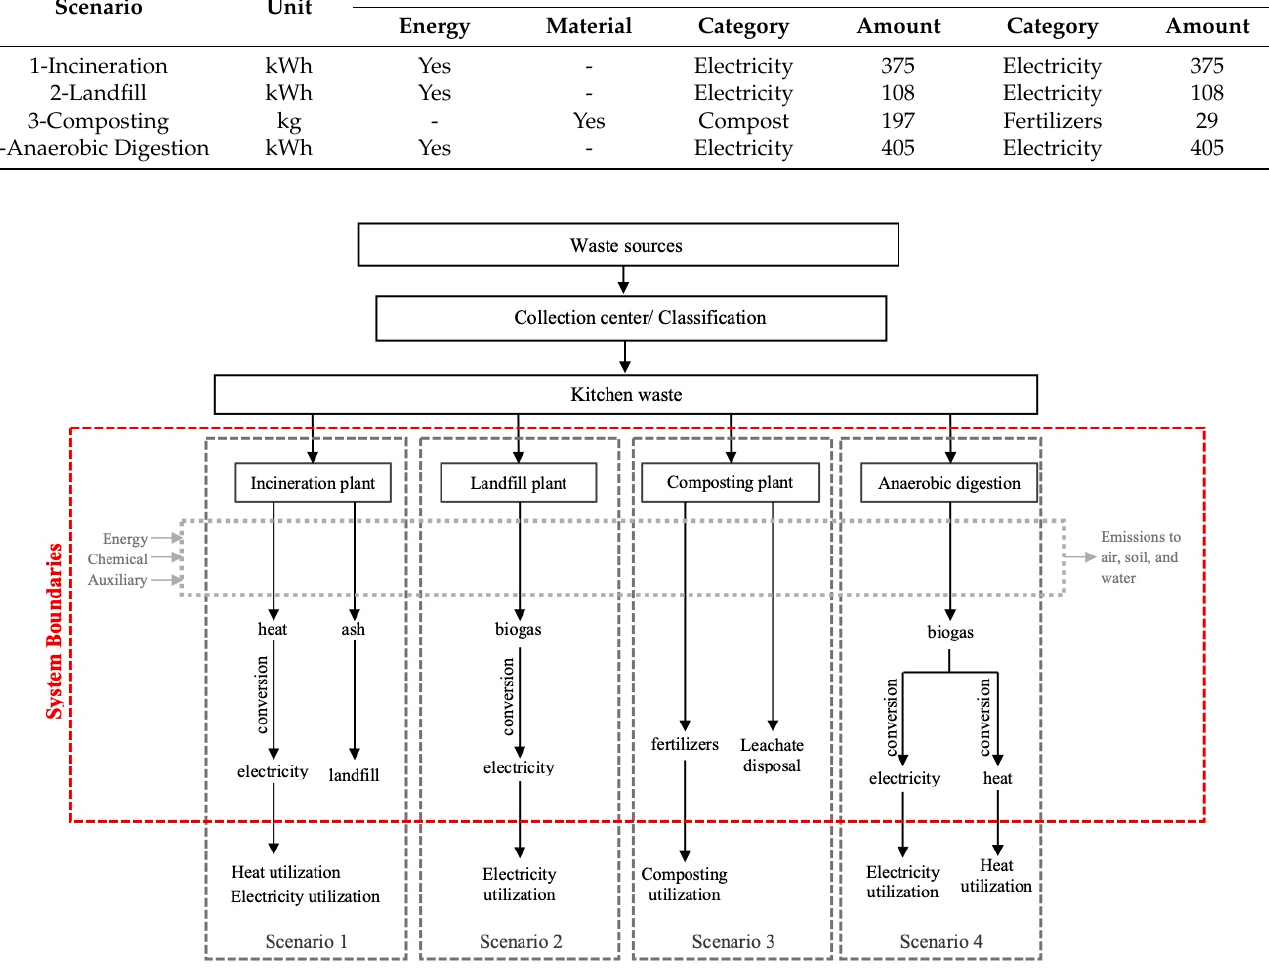
Figure 1. The system boundaries of the four scenarios studied on kitchen waste treatment.